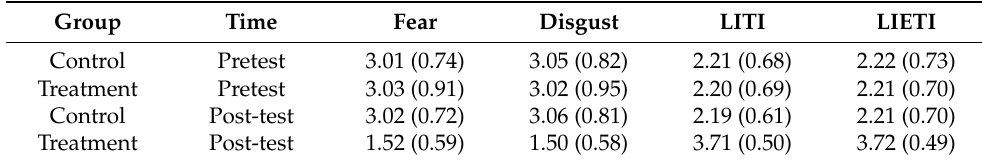
Table 1. Mean (Standard Deviations) for Fear, Disgust, LITI, and LIETI Ratings. Group Time